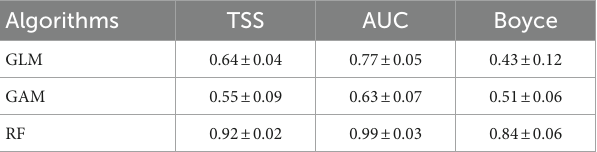
Algorithms: GLM, generalised linear models; GAM, generalised additive models; RF, random forest. Model statistics: TSS, true skill statistic; AUC, area under the curve; Boyce, Boyce index.